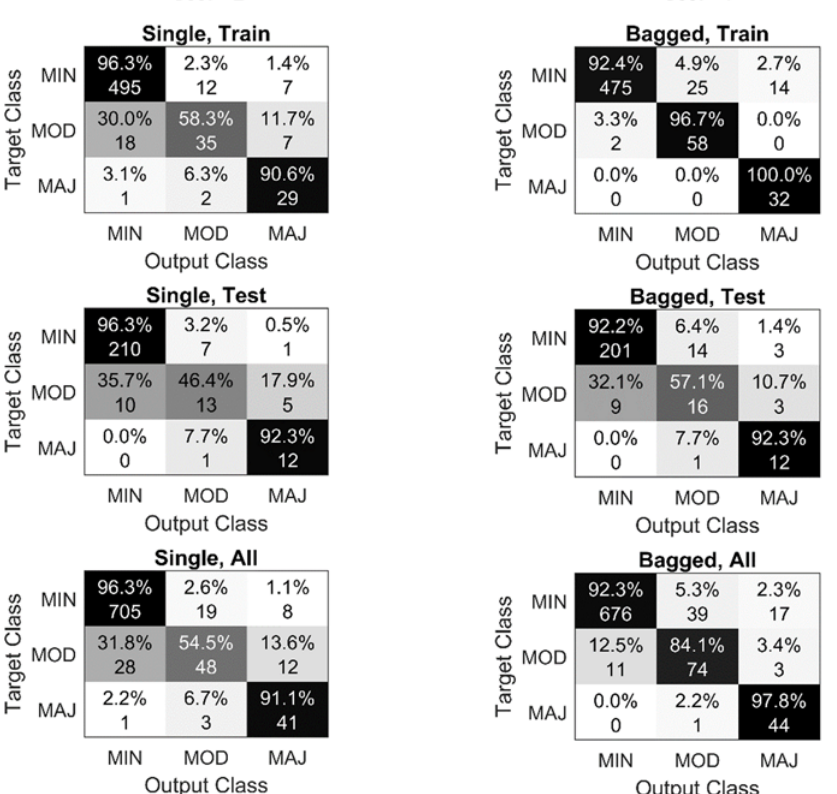
Figure 8. Confusion matrices for the single classification tree ( left ) with custom misclassification cost matrix (c = 2) and for the classification tree ensemble ( right ) with custom misclassification cost matrix (c = 7). Confusion matrices provided based on the training ( top ), testing ( middle ), and combined ( bottom ) data sets.